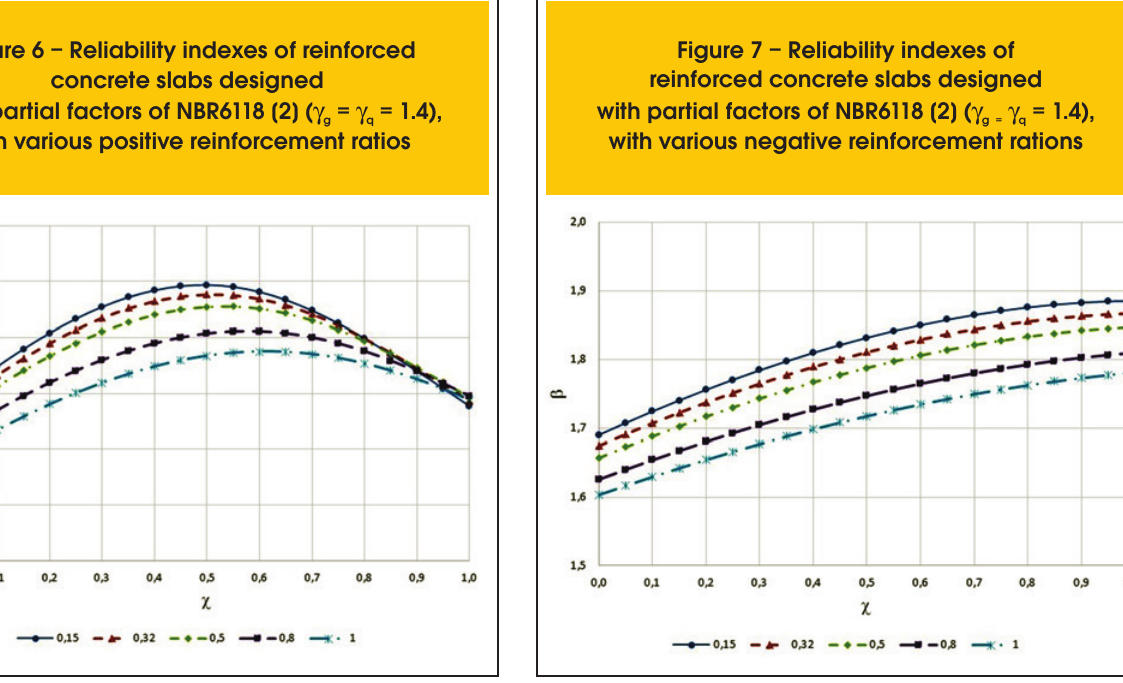
Figure 7 – Reliability indexes of reinforced concrete slabs